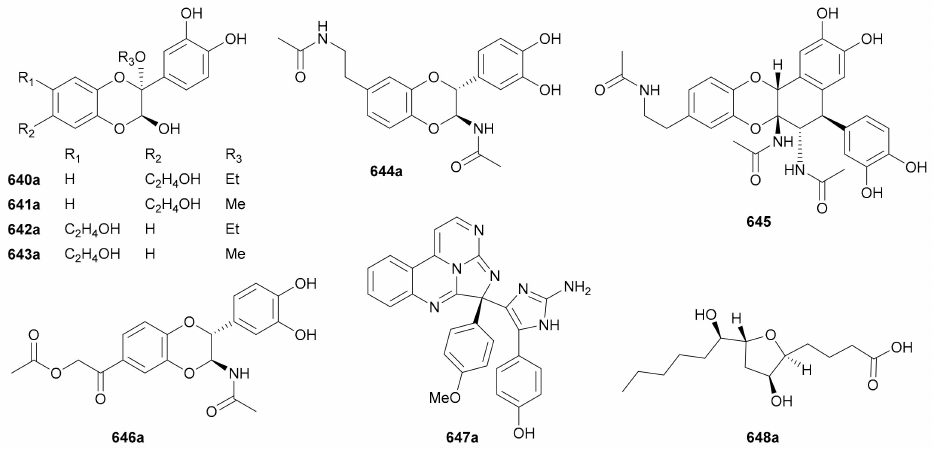
Figure 34. Structures of metabolites from phyla Arthropoda and